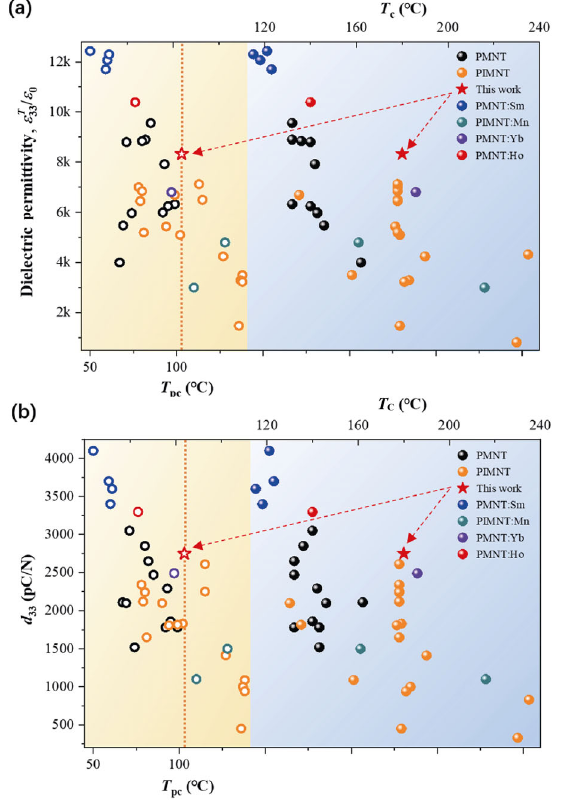
Fig. 3 Temperature dependence of (a) tan δ of PIMN–0.30PT SCs poled by HT DCP, HT ACP [29], and the optimized FC ACP. Fig. 4 (a)